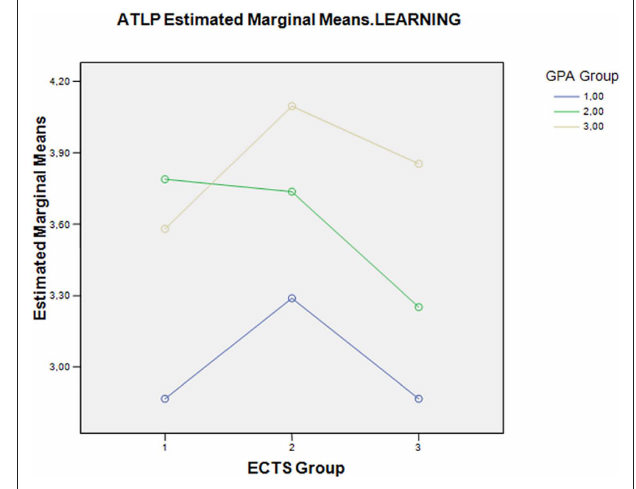
FIguRE 6 | Perception of the teaching process, according to performance level and subject credit load.